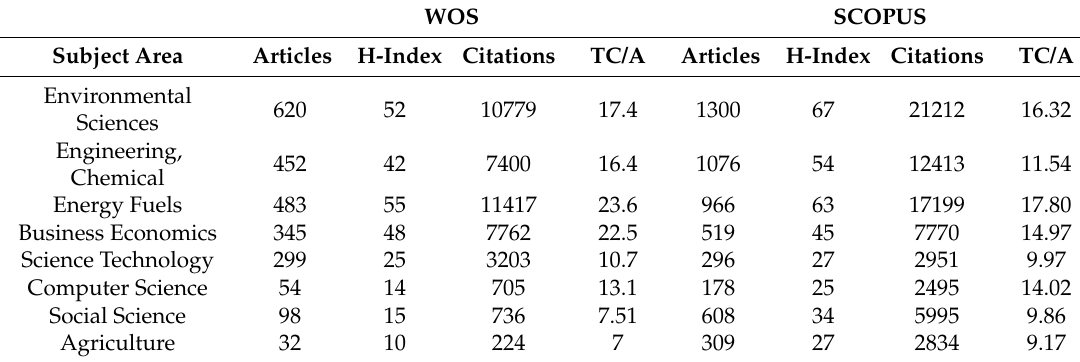
Table 7. Distribution of articles by knowledge areas.